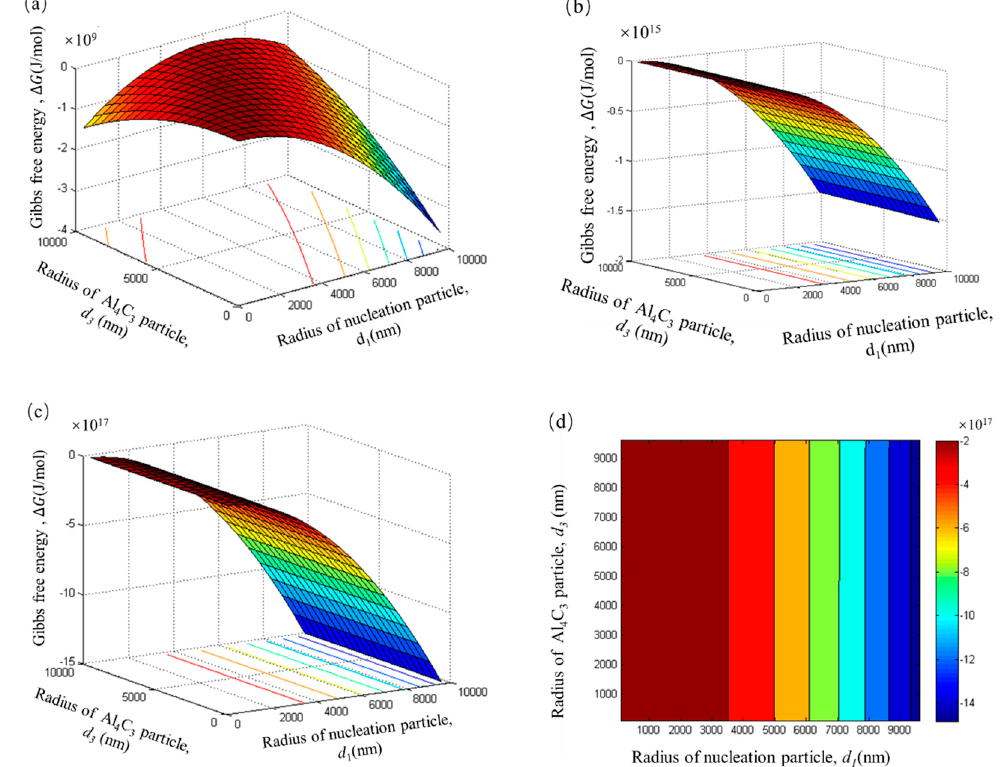
Figure 9. The Gibbs free energy of the duplex phase particle with di ff erent adsorption layers. ( a ) n = 1, ( b ) n = 100, ( c ) n = 1000, ( d ) the contour map of the n = 1000.